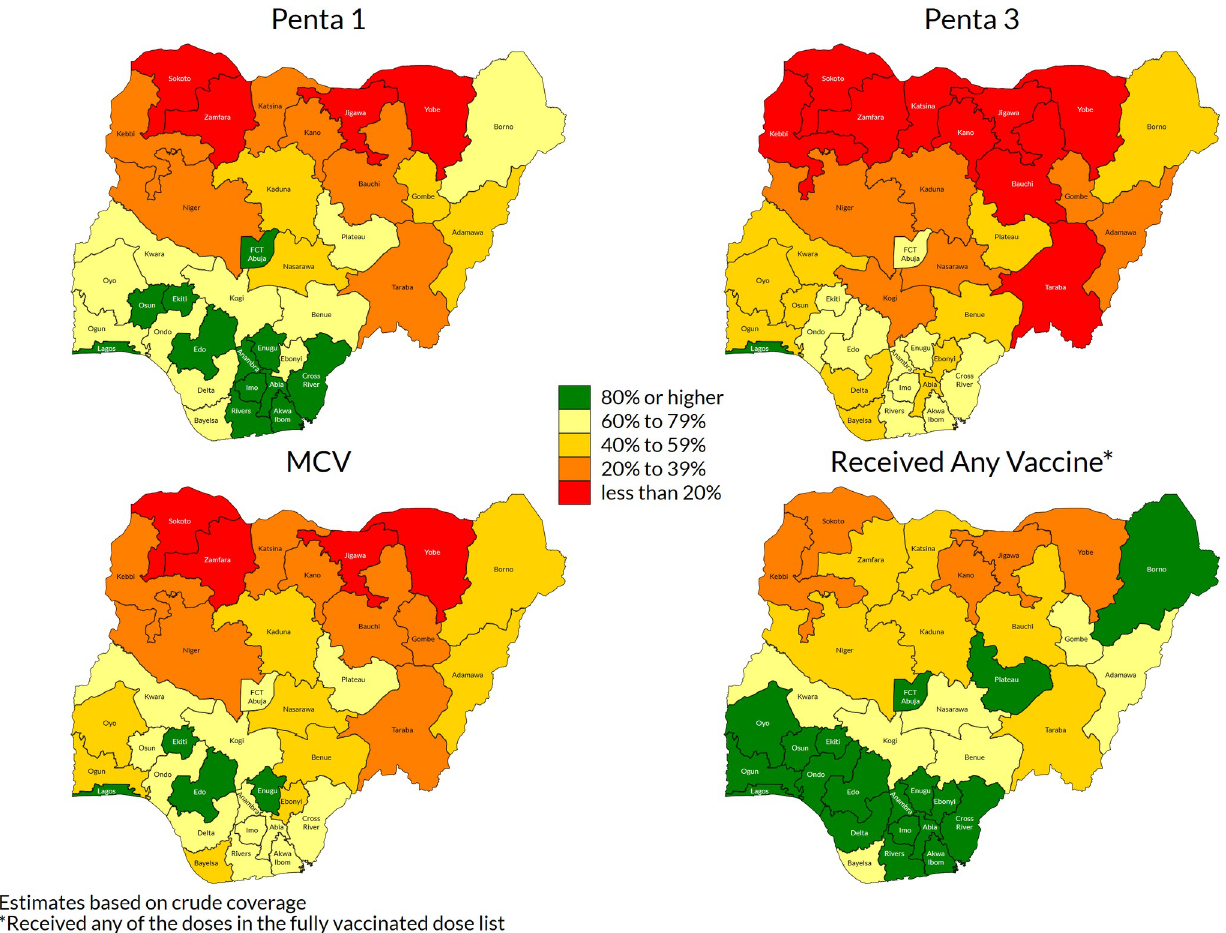
Fig 2. Weighted crude coverage of first and third dose of pentavalent vaccine, of measles vaccine and of any of the basic vaccines, children aged 12– 23 months, by state, Nigeria MICS/NICS 2016–17.